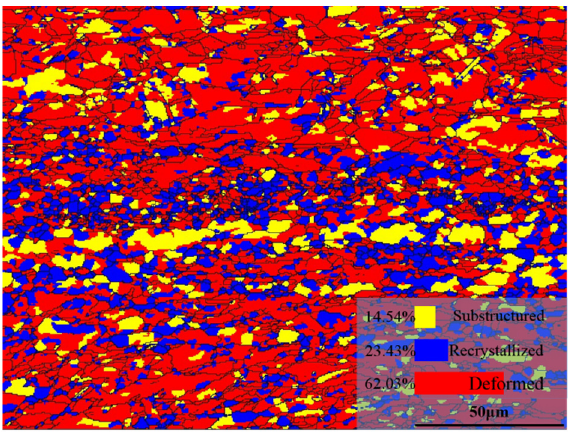
Figure 18. EBSD recrystallization fraction statistics graph of the welded joint.